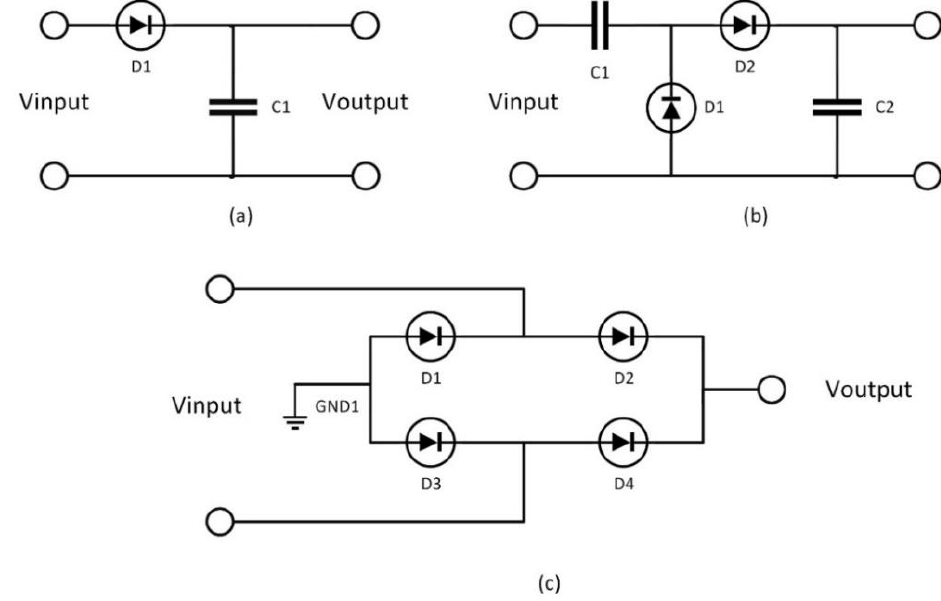
Figure 8. Types of rectifier configurations ( a ) half-wave rectifier ( b ) full-wave rectifier ( c ) bridge rectifier [1].